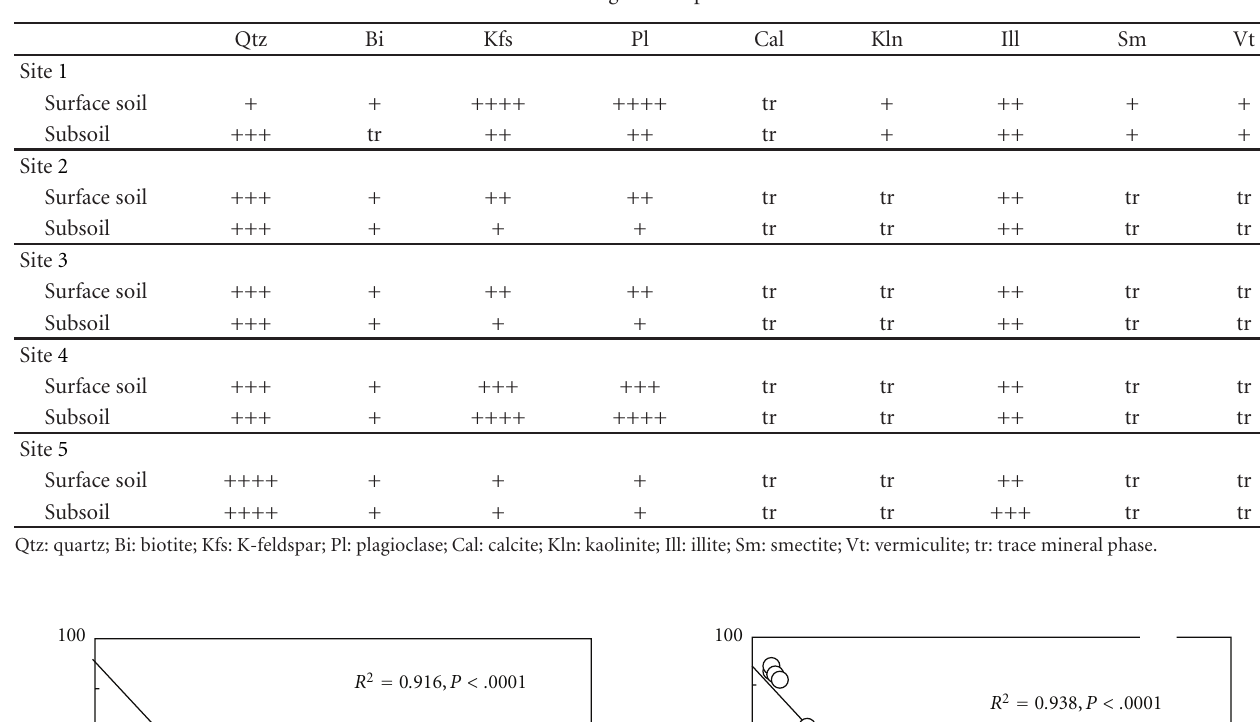
Table 6: Mineralogical composition of soil.